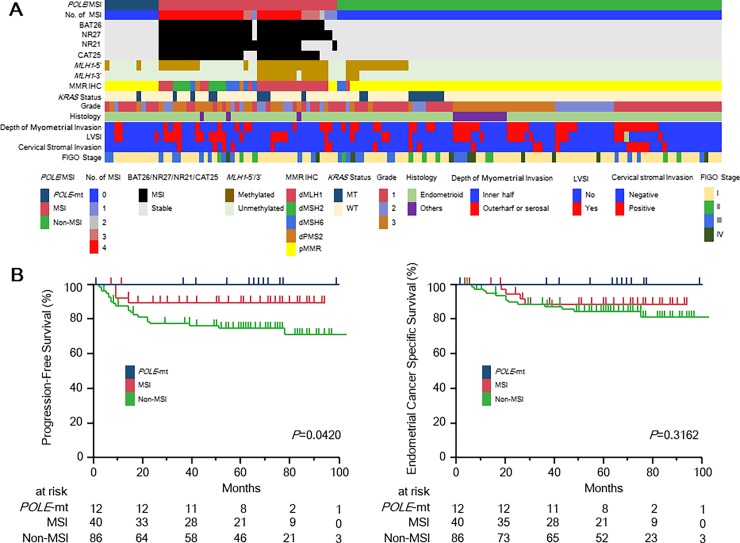
Molecular and clinic-pathological features of 138 ECs.(A) Molecular and clinic–pathological landscape of 138 ECs. Genetic analysis, focusing on frequent hotspot mutations in the POLE gene, and MSI status result in the identification of three molecular subgroups: (1) POLE-mutant, (2) MSI and (3) non-MSI. (B) Progression-free survival and endometrial cancer-specific survival of 138 EC patients stratified by genetic profiles. P values were calculated by the log-rank test.